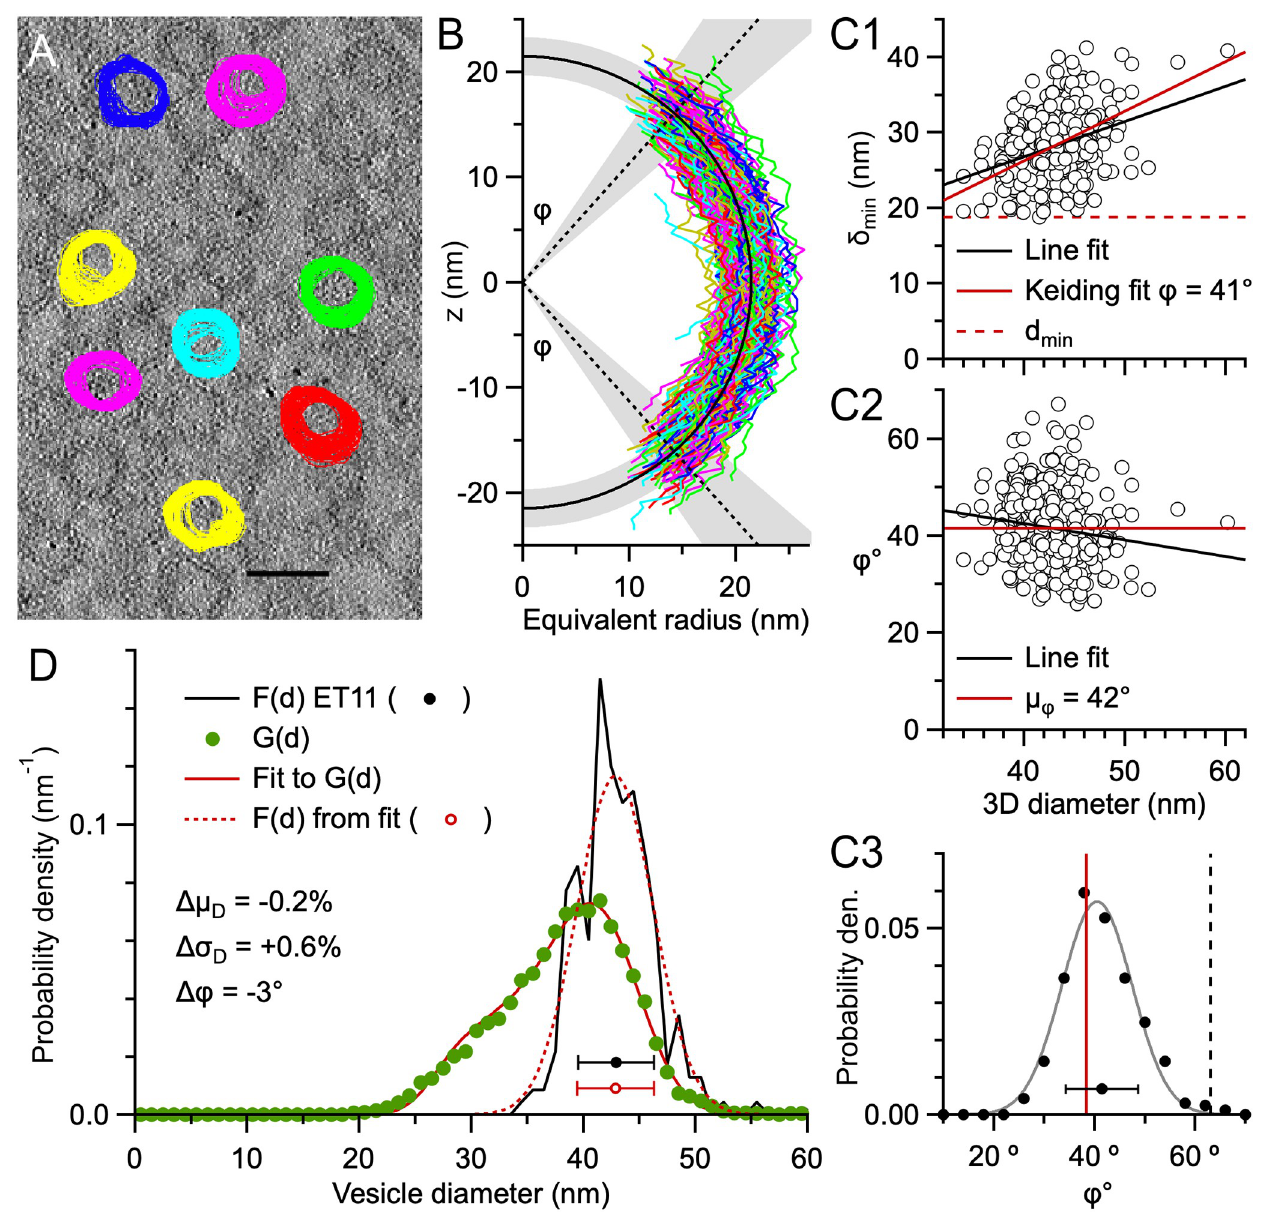
Fig 6. The Keiding model accurately estimates F(d) and ϕ from G(d) for true ϕ < ϕ cutoff (vesicles ET11). A. One of 261 serial images of a 3D ET reconstruction (ET11) of a cerebellar MFT section 138 nm thick. 271 vesicles, including 101 caps, were tracked and outlined through multiple z-planes and their d area computed as a function of z-plane number (z # ). This image shows outlines for 8 representative vesicles, overlaid with outlines from images above and below. Scale bar 50 nm. B. Vesicle xy-radius ( ½ d area ) vs. z-depth (colored lines) with vesicle centers (z 0 ) aligned at z = 0; caps are not displayed. Black semi- circle and shading denote μ D ± σ D = 42.9 ± 3.4 nm for all measured 3D diameters (D; n = 233). Black dotted lines and shading denote measured ϕ : μ ϕ ± σ ϕ = 41.5 ± 7.2˚ (n = 403, measures of north and south poles, including caps). Parameters z 0 and D were estimated via a curve fit to Eq 10 and ϕ = sin -1 ( δ min /D), where δ min is the minimum d area at a given pole (S6A Fig in S1 File). Average fit E = 1.00 ± 0.16 (n = 233) where estimated S z = 0.53 nm (S6B Fig in S1 File). Fits to the smallest caps were not included (n = 38). C1. Minimum 2D diameter of a given vesicle ( δ min ) vs. D (circles; n = 403) with line fit (black line; χ 2 = 5957, r = 0.4, R 2 = 0.1) and Keiding-model fit (red solid line; δ min = D � sin ϕ ; fit ϕ = 41.0 ± 0.3˚; χ 2 = 6105, r = 0.4, R 2 = 0.3). The smallest δ min (d min = 19 nm; red dashed line) is a poor match to the data. C2. Same as C1 but for ϕ = sin -1 ( δ min /D) with line fit (black line; r = -0.1, R 2 = 0.02) and μ Probability density (per ˚) of measured ϕ in C2 (black circles; probability per degree) with Gaussian fit (gray line; Eq 5) and fit ϕ (red line) and ϕ cutoff from D (black dashed line; ~63˚; Eq 8). Note, the difference between the fit and measured ϕ ( Δ ϕ = -3˚) can partially be accounted for by an estimated +1˚ discretization error of measured ϕ (S6D Fig in S1 File) and a -0.3˚ error of fit ϕ from assuming a fixed ϕ (S10C Fig in S1 File). D. Measured F(d) (black line and circle; 1 nm bins; see B ) vs. G(d) (green circles; n = 13,914 outlines; 1 nm bins). A curve fit of Eq 1 to G(d) (red solid line; μ D = 42.9 ± 0.1 nm, σ D = 3.4 ± 0.1 nm, ϕ = 38.4 ± 0.3˚; T fixed to 0 nm) resulted in estimated F(d) (red dotted line and circle) nearly the same as measured F(d) and estimated ϕ nearly the same as μ ( C3 ). See S6–S10 Figs in S1 File.